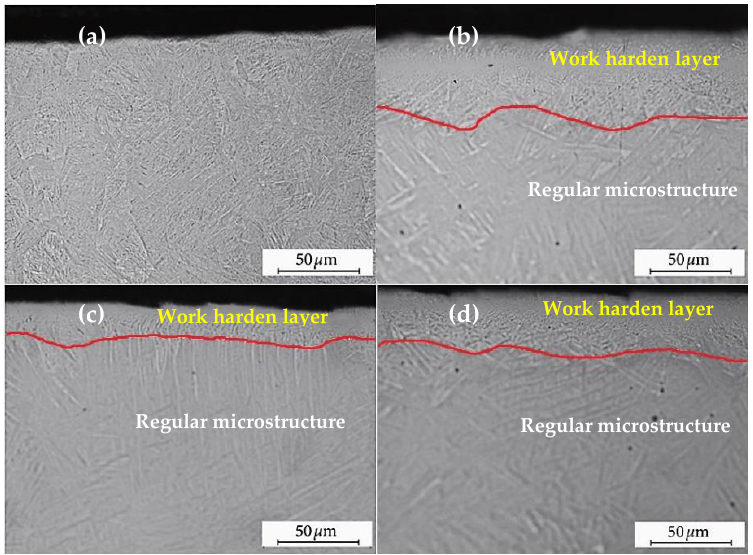
Figure 8. The cross-section of specimens showing modified surface layer after shot peening using the pressure of 0.4 MPa: (a) unmodified surface after DMLS (reference sample); (b) shot made of CrNi steel; (c) nutshell granules; (d) ceramic beads, author ’ s elaboration based on [146].